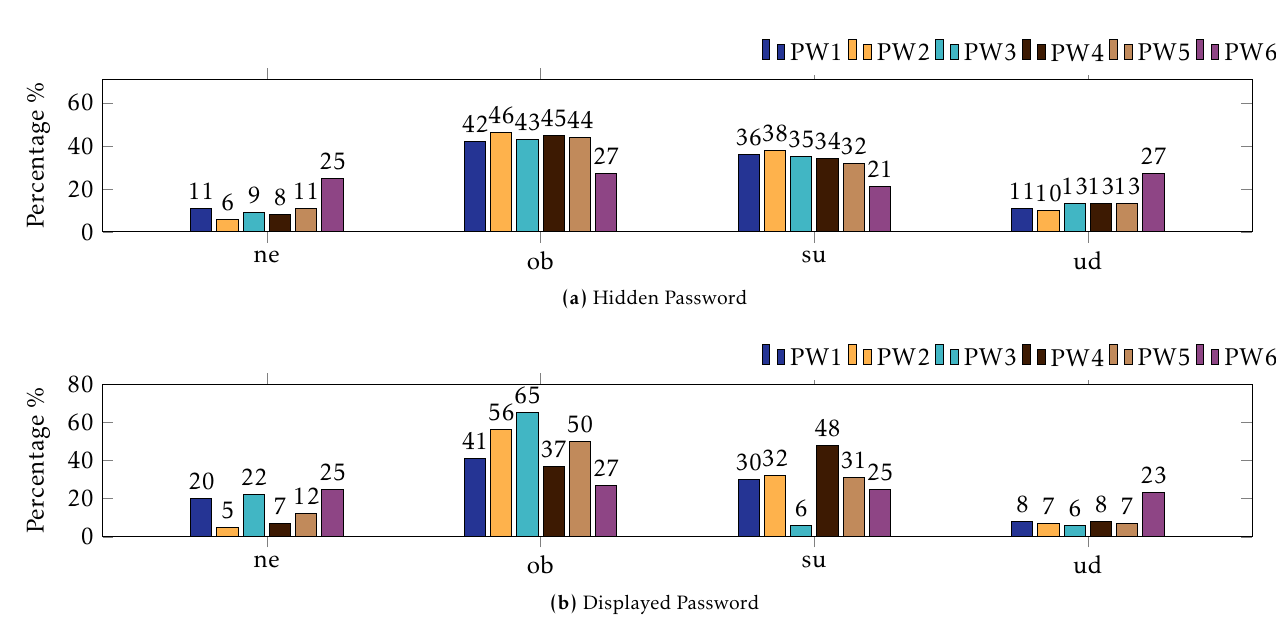
Figure 5. Percentages of participants’ answers for all six passwords when they were hidden and